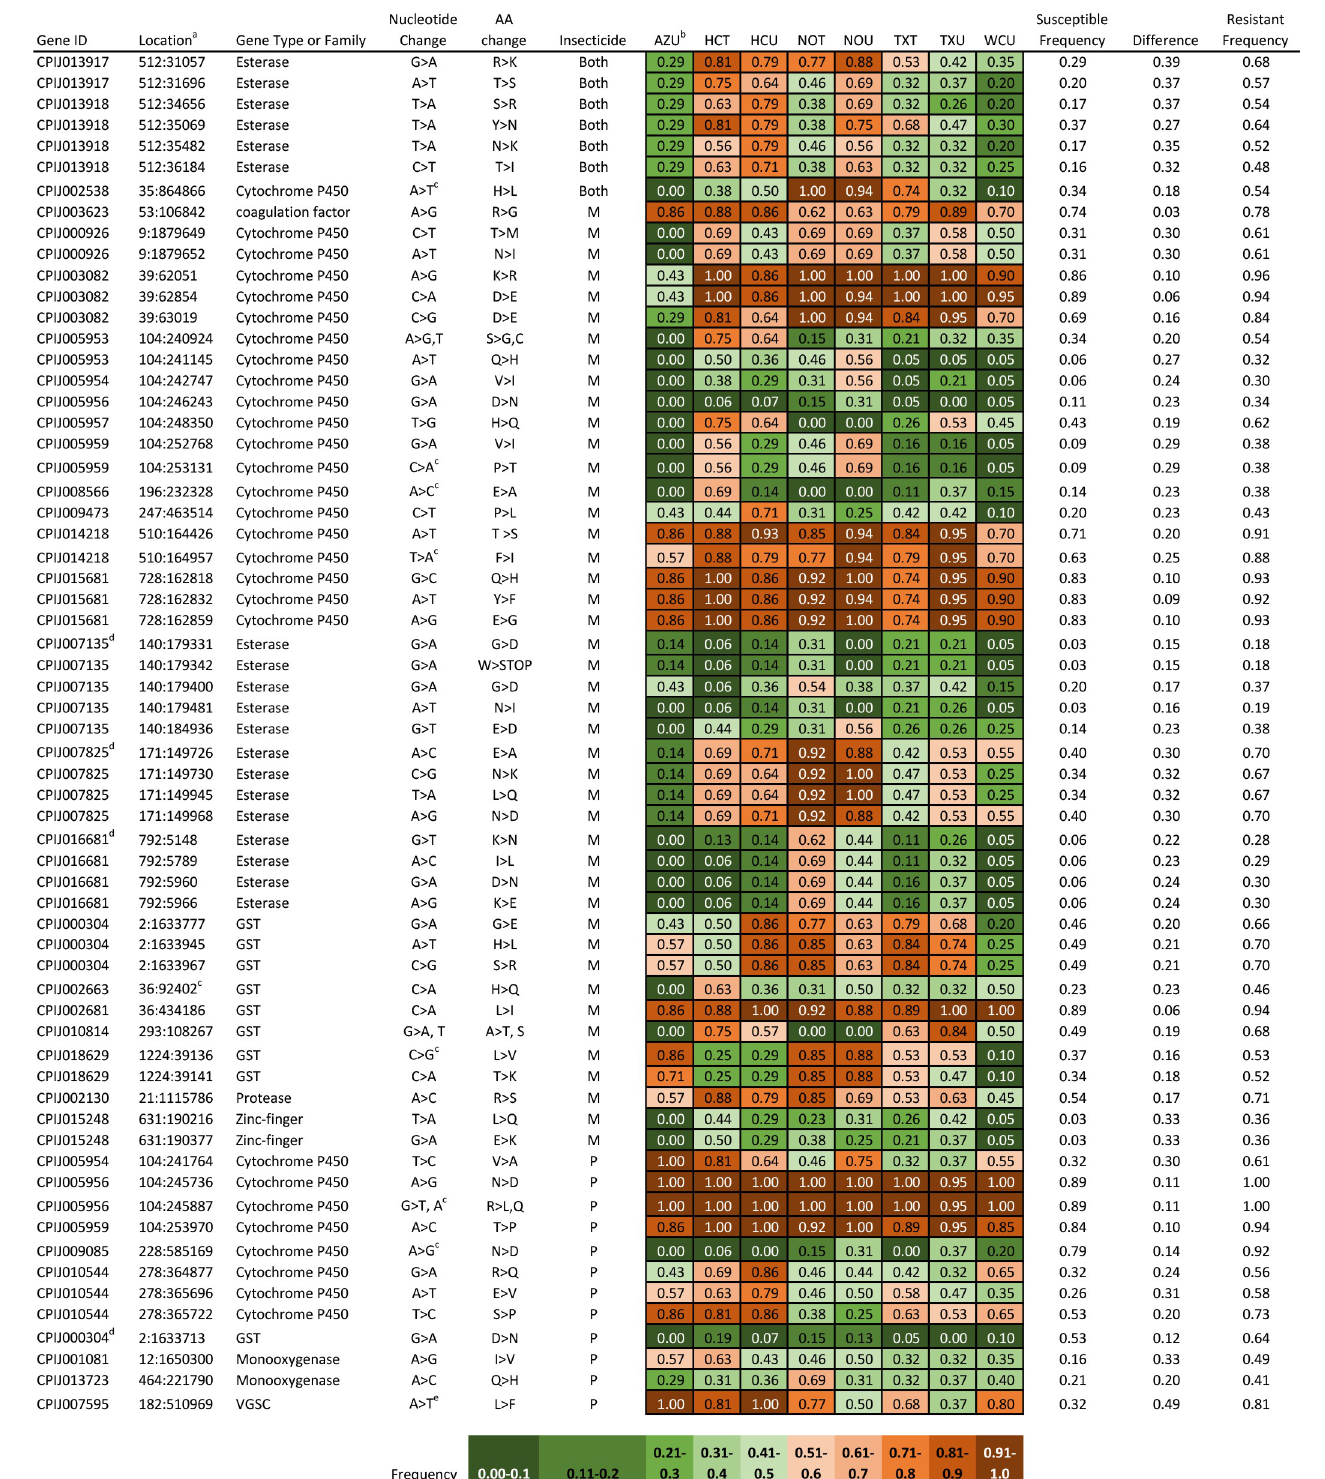
Fig 3. Non-synonymous SNPs (listed as supercontig:position) associated with resistance to malathion (M), permethrin (P), and both insecticides, as well as SNP frequency per population and frequency of each SNP in susceptible vs. resistant phenotype individuals overall. a Position of significant SNPs in Data Set 3 relative to the supercontig. b See Table 1 for population information. c SNP occurs in functionally conserved region of the gene (See Table 5). d "expansion" gene as per Yan et al. 2012. e This is the L1014F kdr mutation.